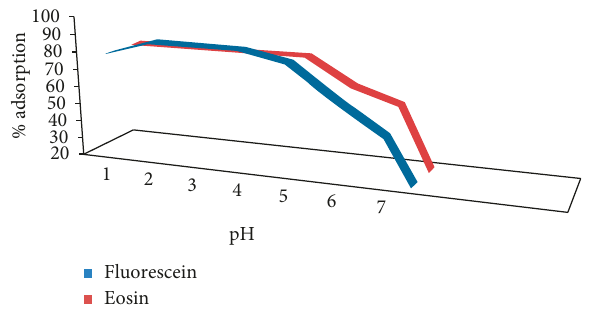
Figure 8: Comparative sorption efficiency of the base-treated WMP at different pH values for removing fluorescein and eosin dyes.